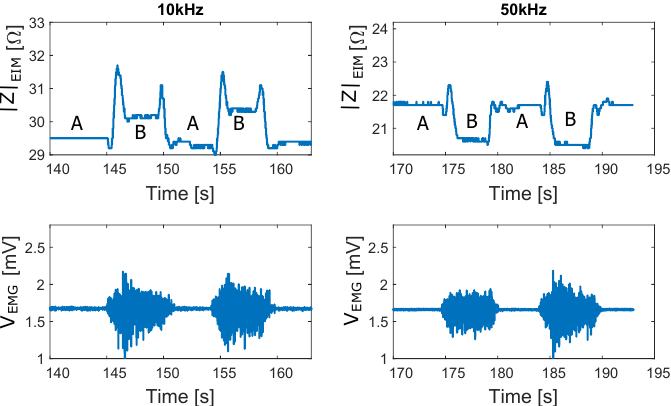
Figure 15. EIM and EMG signals measured from a test subject during movement with contraction. Measurement performed at 10 and 50 kHz. A: marks the period when the volunteer had their leg bent at 90 degrees. B: marks when the leg was elongated to 140 degrees.